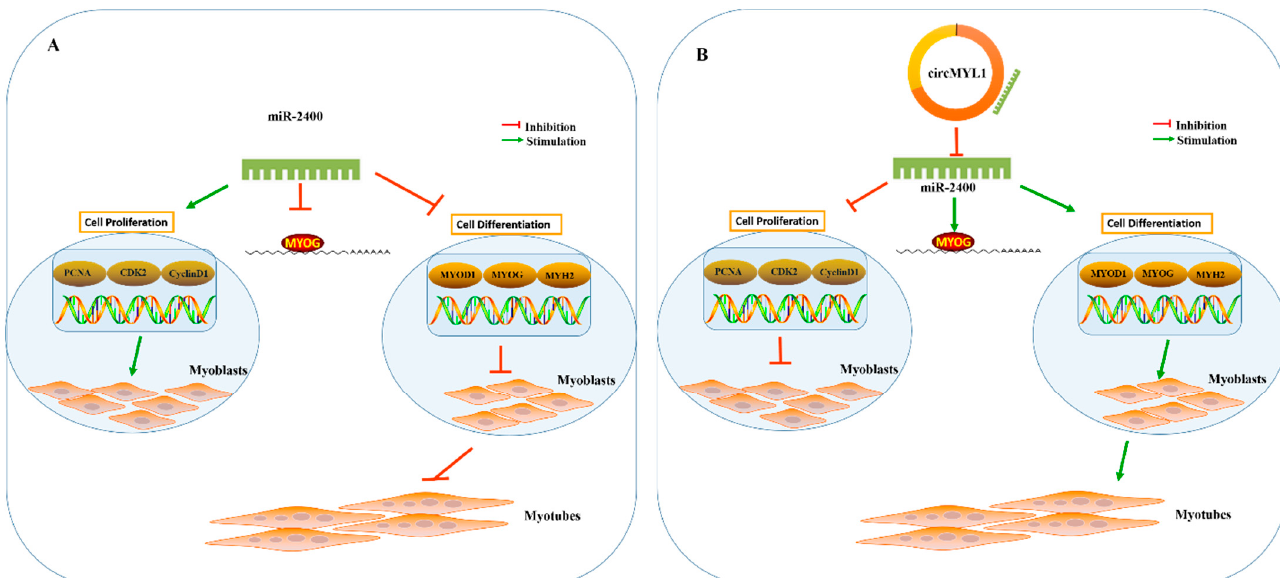
Figure 9. Schematic mechanism of miR-2400 and circMYL1 in regulating bovine myogenesis. ( A ) MiR-2400 regulates myogenesis by targeting MYOG. MiR2400 promotes the proliferation of bovine primary myoblasts through the up-regulation of proliferation marker genes PCNA , CDK2 , and CyclinD1 . MiR-2400 inhibits the differentiation of bovine primary myoblasts through the negative regulation of differentiation marker genes MyoD , MyoG , and MYH2 . ( B ) CircMYL1 regulates myogenesis by acting as a ceRNA for miR-2400 to activate MYOG. CircMYL1 inhibits the proliferation of bovine primary myoblasts through negative regulation of proliferation marker genes PCNA , CDK2 , and CyclinD1 . CircMYL1 promotes the differentiation of bovine primary myoblasts through the up-regulation of differentiation marker genes MyoD , MyoG , and MYH2 .